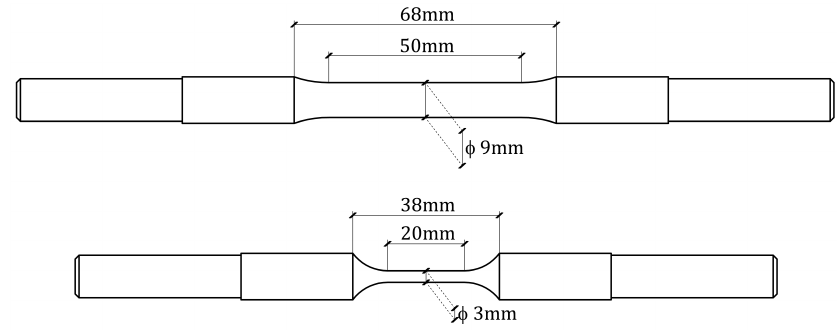
Figure 4. Specimens